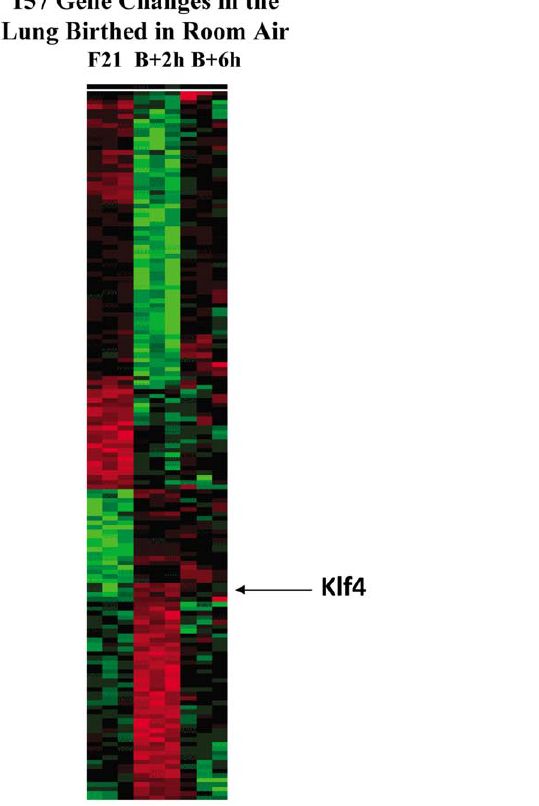
Figure 1. Transcriptional profile of gene expression in lung at birth in room air. Heirarchical cluster of the 157 genes that were up- regulated (red) or down-regulated (green) after birth (B) in room air at 2 h (B + 2) and 6 h (B + 6) compared to one day prior to birth on the last day of gestation (fetal day 21: F21). Four patterns are evident: transient up or down regulation and persistent up or down regulation. Arrow denotes Kruppel-like factor 4 (Klf4), a transcriptional regulator that exhibited the highest t-test (p , 0.00001) and the greatest fold change at birth (5-fold).